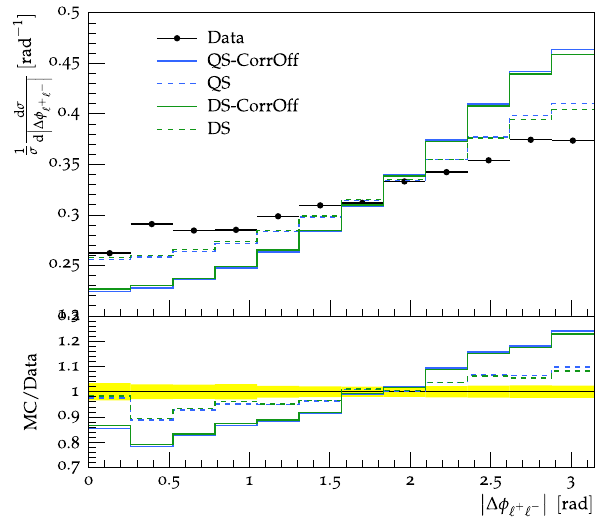
Fig. 5 The difference in azimuthal angle between the planes of two initial-state g → q ¯ q branchings in gg → h 0 predicted using the dipole parton shower (DS) in Herwig 7. The dipole parton shower (DS- CorrOff) prediction without spin correlations is also included. Predic- tionsobtainedusingthedipolepartonshowerrestrictedtoallowbranch- ings from II dipoles only and with a modified handling of splitting recoils,asdescribedinthetext,areshownwith(DS-II)andwithout(DS- II-CorrOff) spin correlations. The result obtained from a sample of LO events generated using MadGraph5_aMC@NLO (LO) is shown for